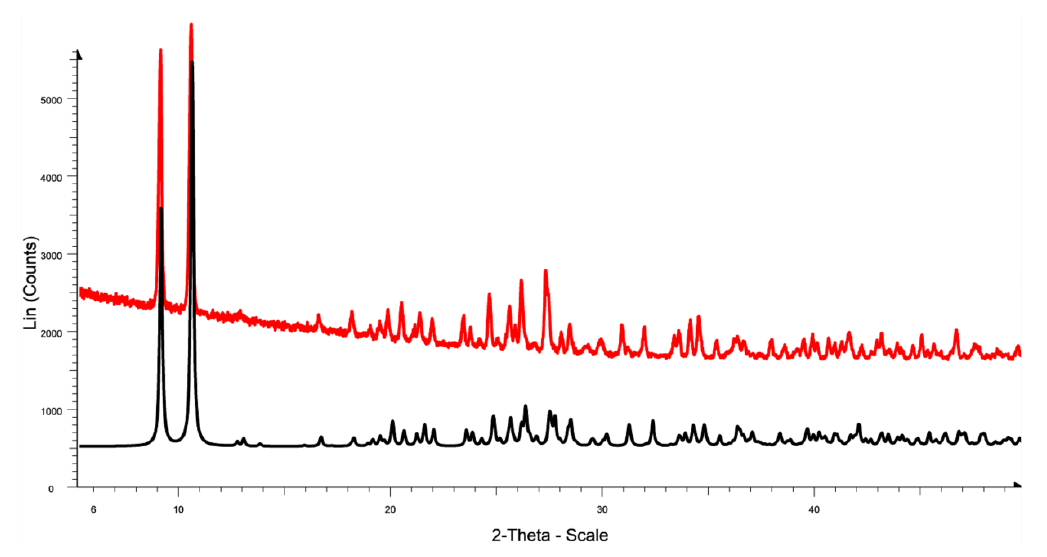
Figure 3. The theoretical powder diffractogram (black curve), calculated from single X-ray data for compound 2 , and the experimental powder diffractograms of the polycrystalline sample (red curve).